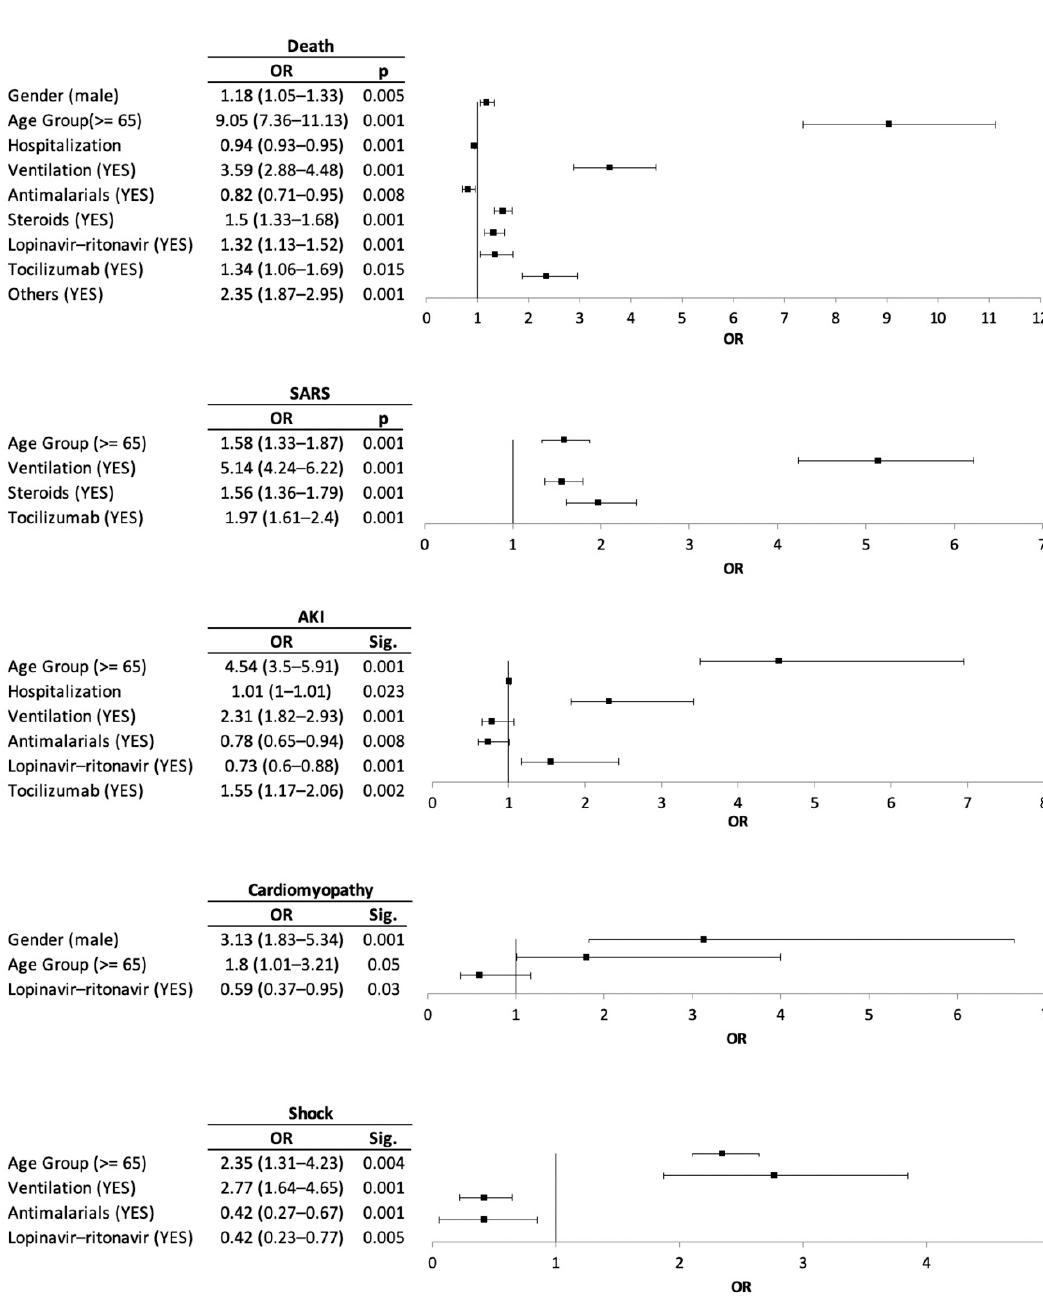
Figure 2. Risk factors for the clinical outcomes and medication prescribed.